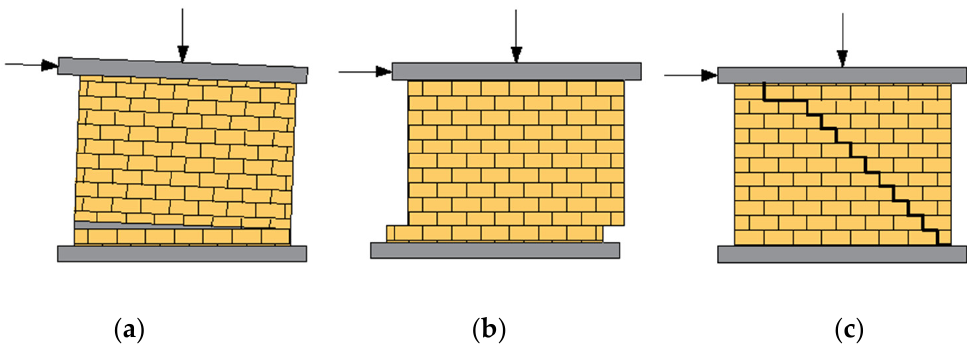
Figure 1. Type of failure modes: ( a ) rocking, ( b ) bed ‐ joint sliding, ( c ) shear failure [24]. Which mechanics will be activated depends on the wall geometry (height/width ratio), quality of materials, the ratio of the compression shear stresses ( σ / τ ), and boundary restraints